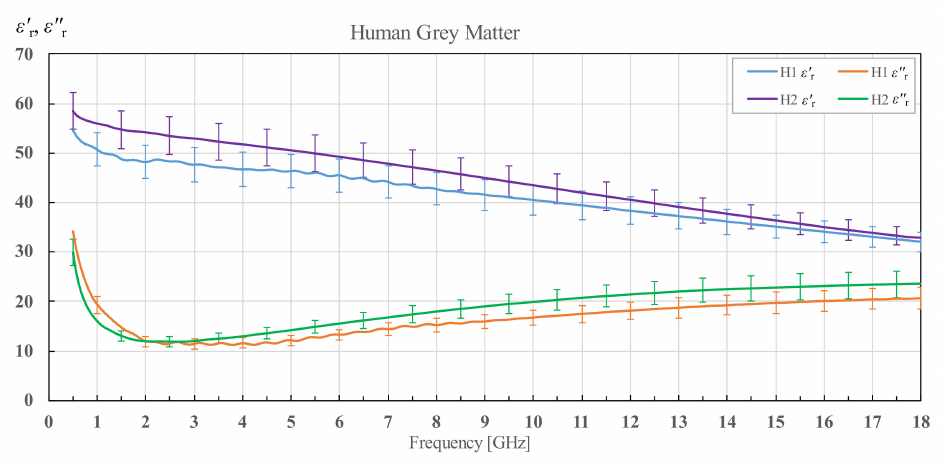
Figure 5. Permittivity of human grey matter for brains H1 and H2 with corresponding standard